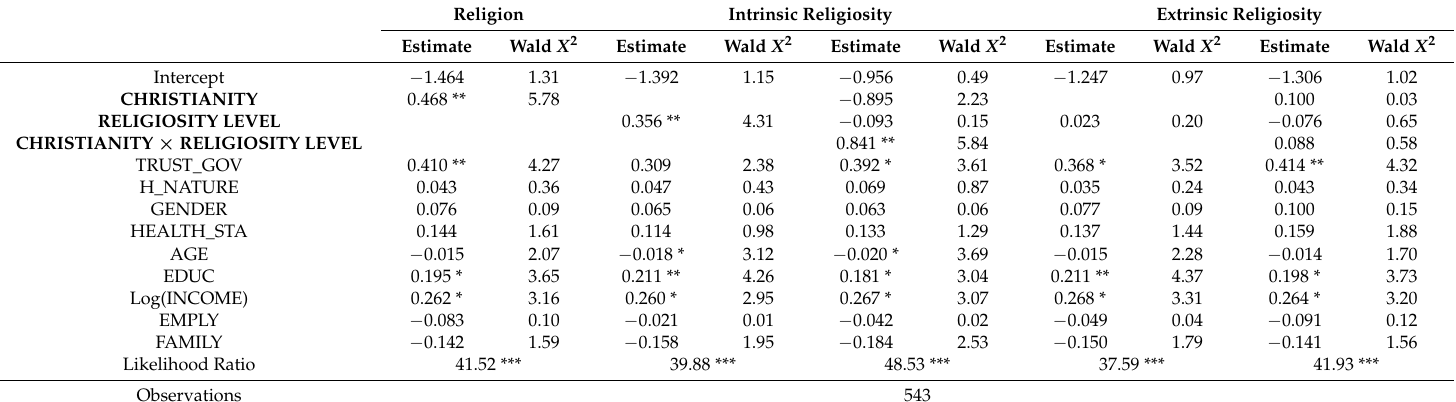
Table 6. The effect of Christianity and religiosity level on the willingness to donate